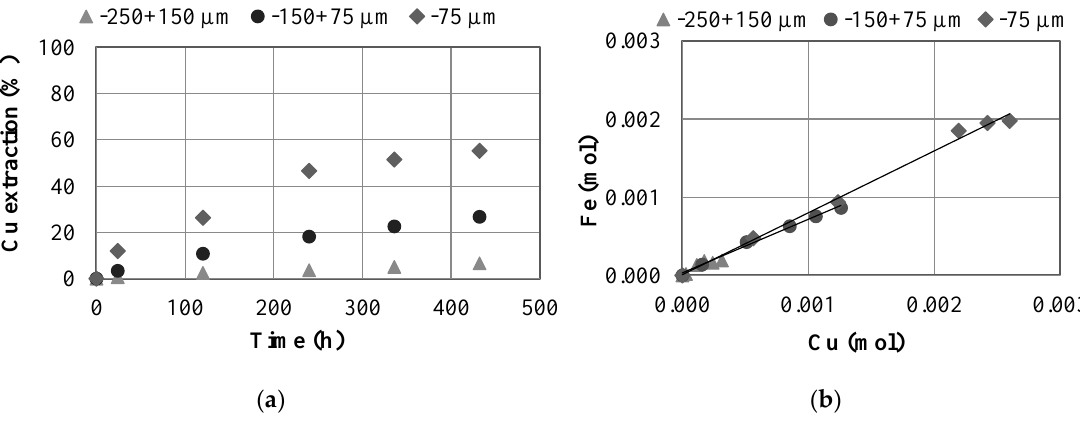
Figure 4. ( a ) Copper extraction (%) versus time (h) at di ff erent particle size: − 250 + 150 µ m, − 150 + 75 µ m and − 75 µ m. ( b ) Cu / Fe molar ratio at di ff erent particle size: − 250 + 150 µ m, − 150 + 75 µ m and − 75 µ m. Experimental conditions: [NaNO 3 ] = 0.7 M, [H 2 SO 4 ] = 0.7 M, seawater as dissolvent, S / L ratio 2 g / L, 45 ◦ C, 350 rpm, sample